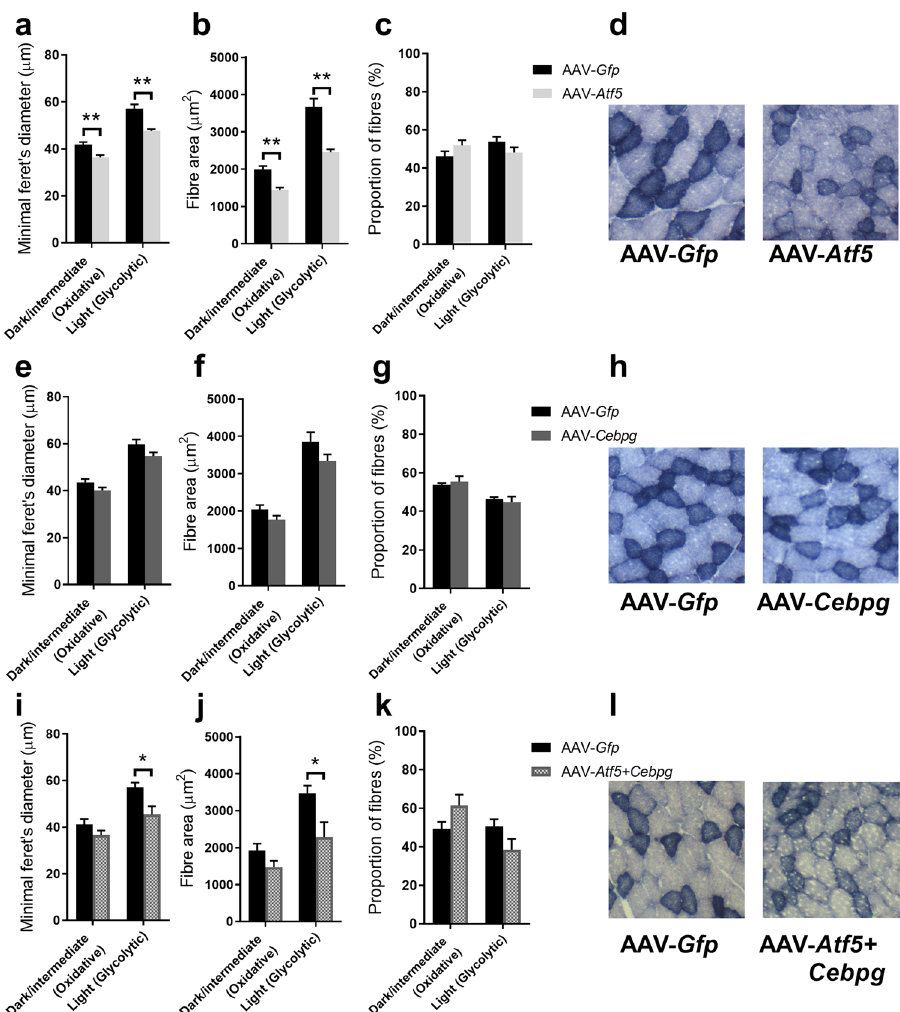
Figure 8. Effect of AAV-mediated overexpression of Atf5 and Cebpg individually and in combination (AAV- Atf5 ± Cebpg ) on muscle fibre size and composition of transduced TA. Succinate Dehydrogenase (SDH) staining was performed on 10 µm sections collected from TA muscle transduced with AAV- Atf5 ( a – d ), AAV- Cebpg ( e – h ) or AAV- Atf5 + Cebpg ( i – l ) for 28 days and the contralateral TA muscle transduced with AAV- Gfp . Average minimal feret’s diameters ( a , e , i ) and fibre areas ( b , f , j ) were determined for 15 oxidative (dark/intermediate) and 15 glycolytic fibres per field of view. The proportion of dark/intermediate (oxidative) and light (glycolytic) fibres ( c , g , k ) were determined as a percentage of the total number of fibres per field of view. Data presented as Means (n = 4–6) ± SEM, where the average of two or three fields of view were taken per sample). Unpaired t -tests were performed, *( P < 0.05) and **( P < 0.01) indicate a significant difference between AAV-GOI compared to AAV- Gfp control. Representative images were captured at 10 × magnification ( d , h , l